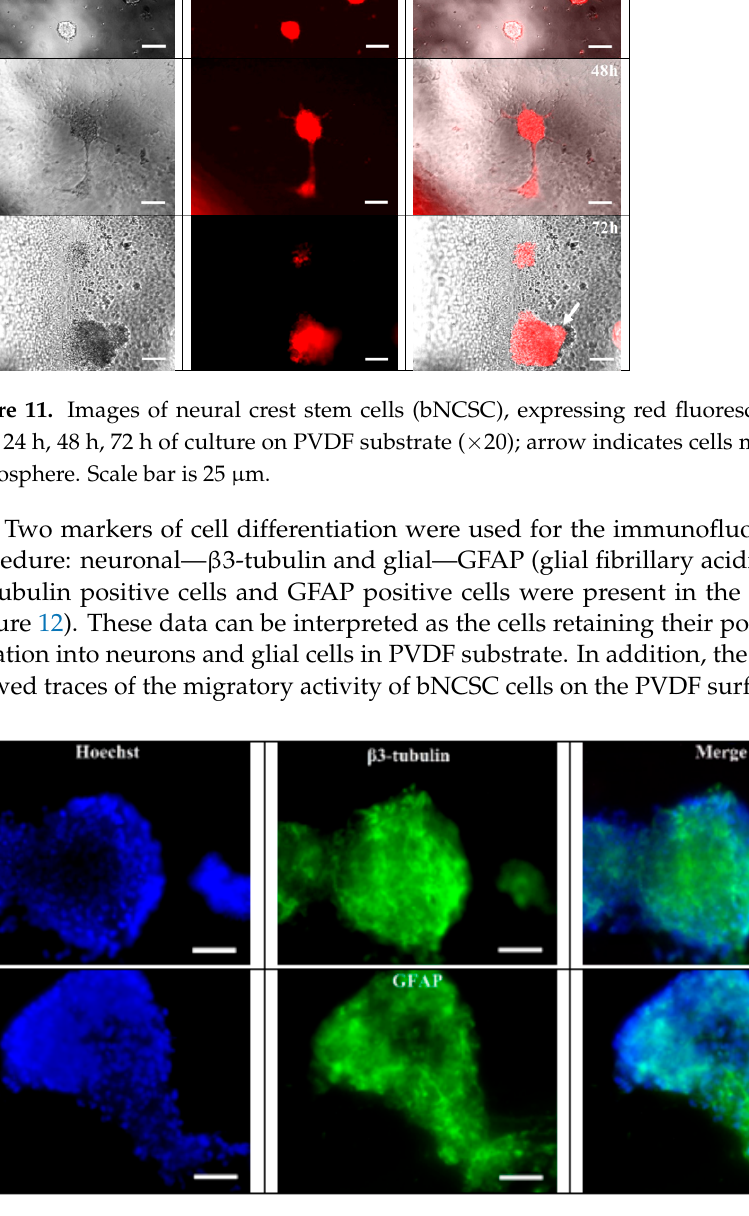
Figure 12. β III-tubulin and GFAP (green) expression bNCSCs growing on PVDF substrate (×40). Blue–Hoechst nuclear stain; arrow indicates cells migrating from the neurosphere. Scale bar = 25 µm.